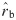
Direct range restriction (DRR): Effects of a weak, moderate, and strong predictive validity on the root mean square error (RMSE) of the estimates of the predictive validity (r^b and r^pb).r^b is the estimate of the biserial correlation coefficient for an artificially dichotomous criterion variable, and r^pb is the estimate of the point-biserial correlation coefficient for a naturally dichotomous criterion variable.